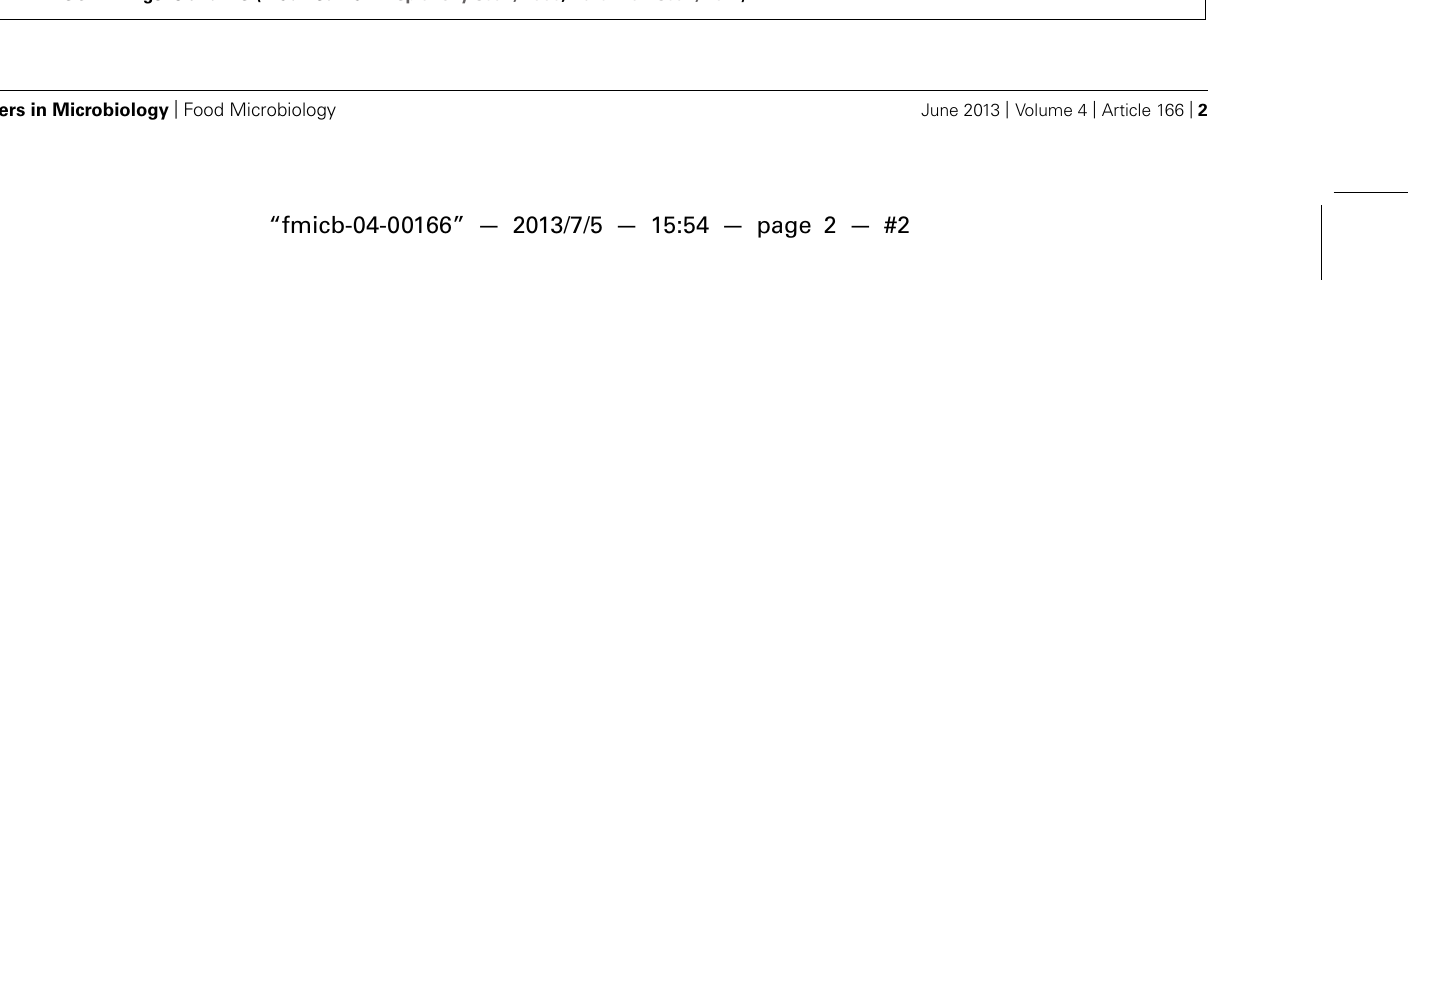
FIGURE 1 | Geographical characteristics and phylogenetic relationship among Saccharomyces species based on the combined sequence analysis of the D1/D2 LSU rRNA gene and ITS (modified from Replansky etal., 2008; Kurtzman etal.,